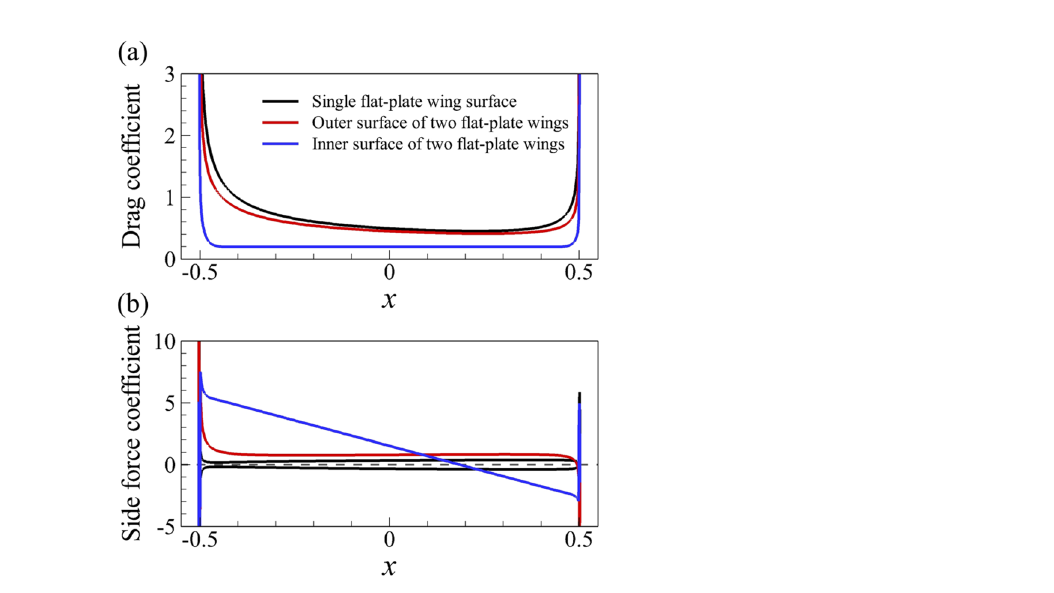
Figure 4. ( a ) The drag coefficient distribution on the single flat-plat wing and one of two flat-plate wings. ( b ) The side force coefficient distribution on one of two flat-plate